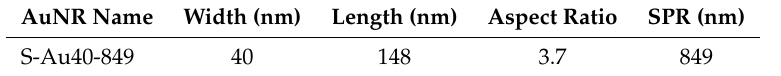
Table 1. Certified dimensions and measured surface plasmon resonance of all AuNRs used in